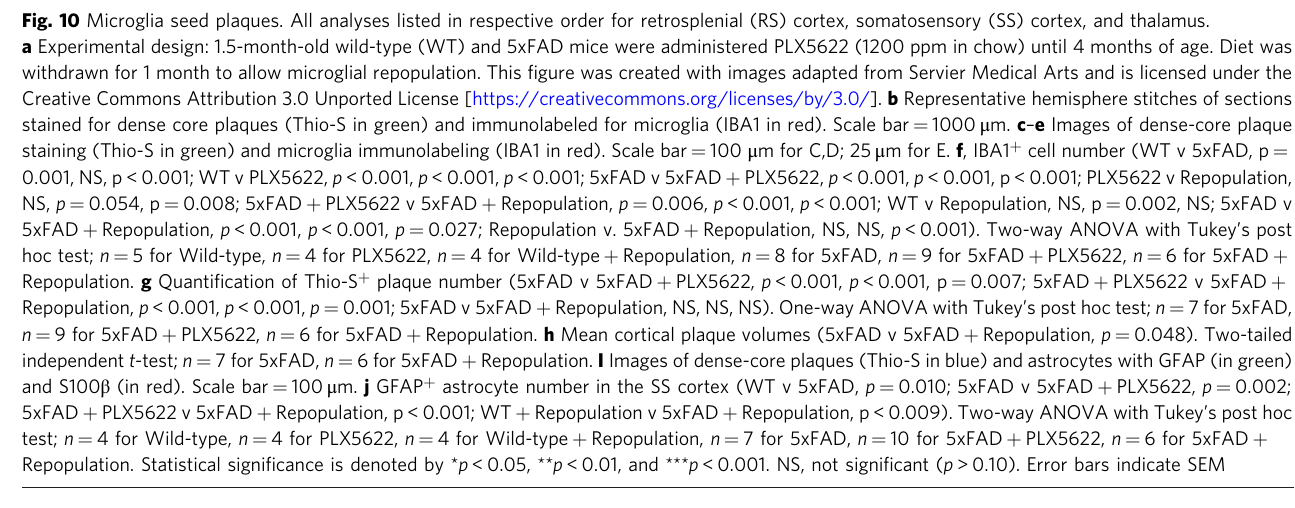
Fig. 10 Microglia seed plaques. All analyses listed in respective order for retrosplenial (RS) cortex, somatosensory (SS) cortex, and thalamus. a Experimental design: 1.5-month-old wild-type (WT) and 5xFAD mice were administered PLX5622 (1200 ppm in chow) until 4 months of age. Diet was withdrawn for 1 month to allow microglial repopulation. This fi gure was created with images adapted from Servier Medical Arts and is licensed under